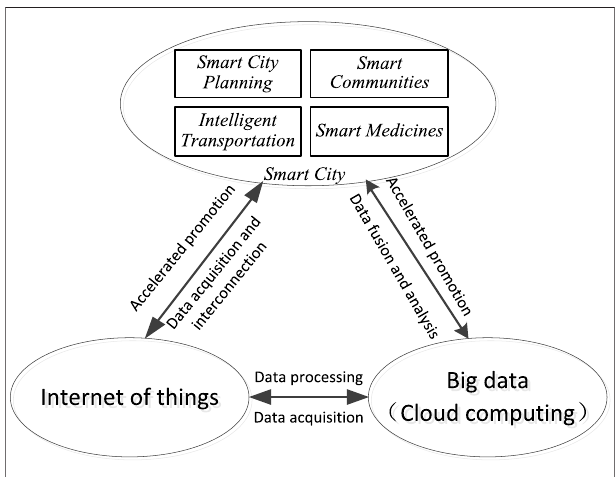
FIGURE 2 | Relationship between big data, smart city, and internet of